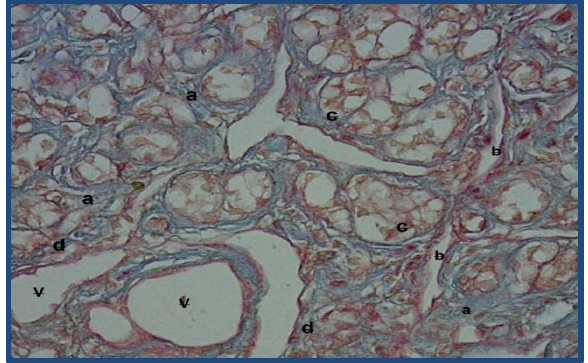
Figure, 12: Ultimobranchial gland showed: a- Collagen fibers b- Sinusoids c- Groups of C-cells d- The groups of C-cells showed adhesive attachment to the outer line of the vesicles (V) (Masson trichrome stain, 40 X).